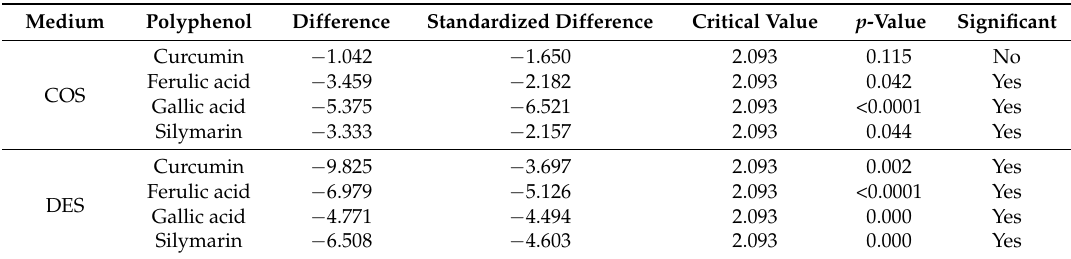
Table 1. Analysis of the differences in radial growth values between treatments with and without AgNPs, for each dispersion medium and polyphenol, with a confidence interval of 95% by Tukey’s HSD test. COS and DES stand for chitosan hydroalcoholic solution and a deep eutectic solvent dispersion medium, respectively.